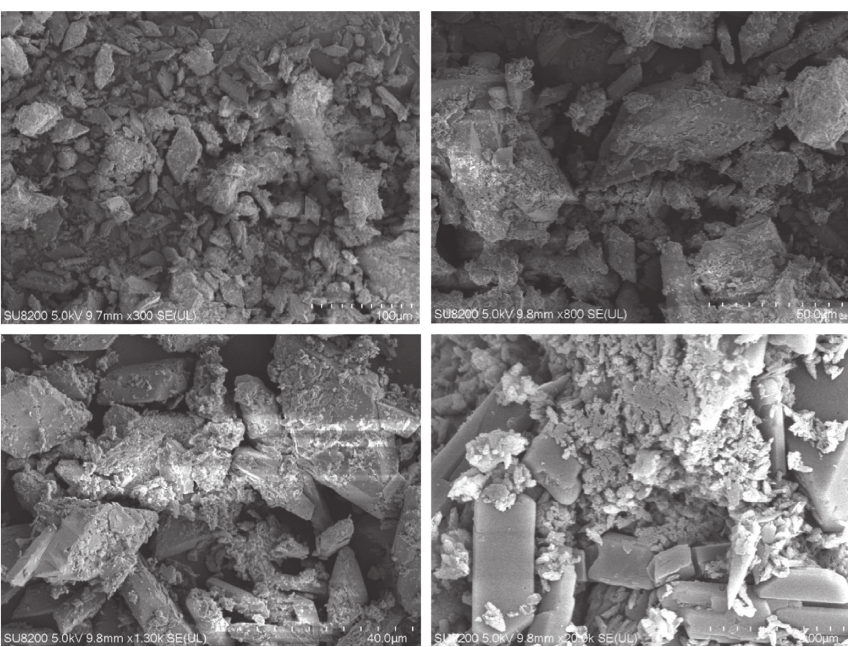
Figure 9: Microstructure of Group